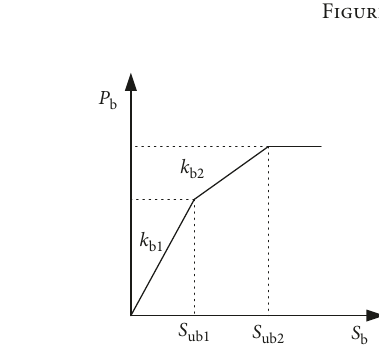
Figure 7: Mobilized pile end loads and share ratios.